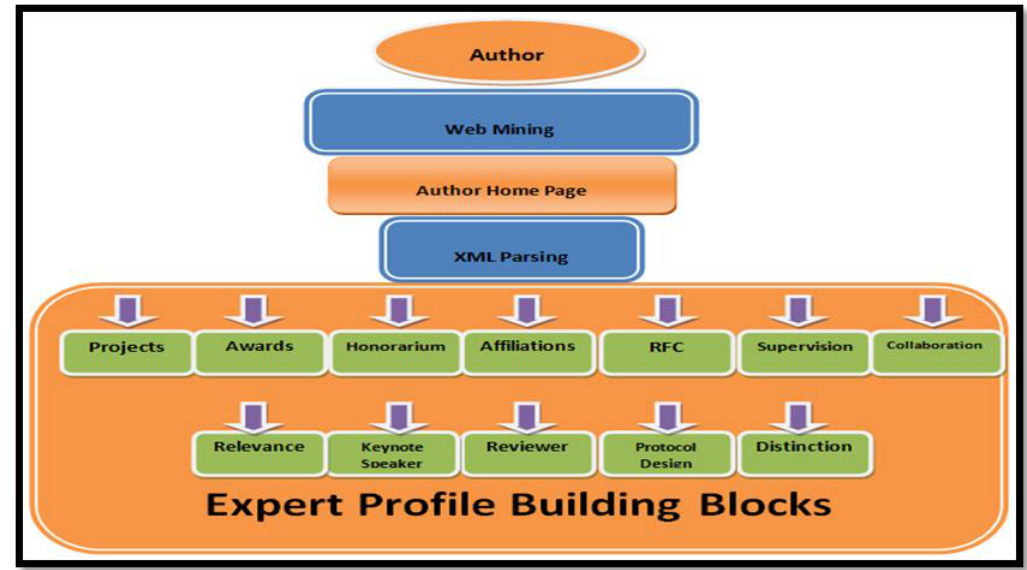
Figure 1. Expert profile building